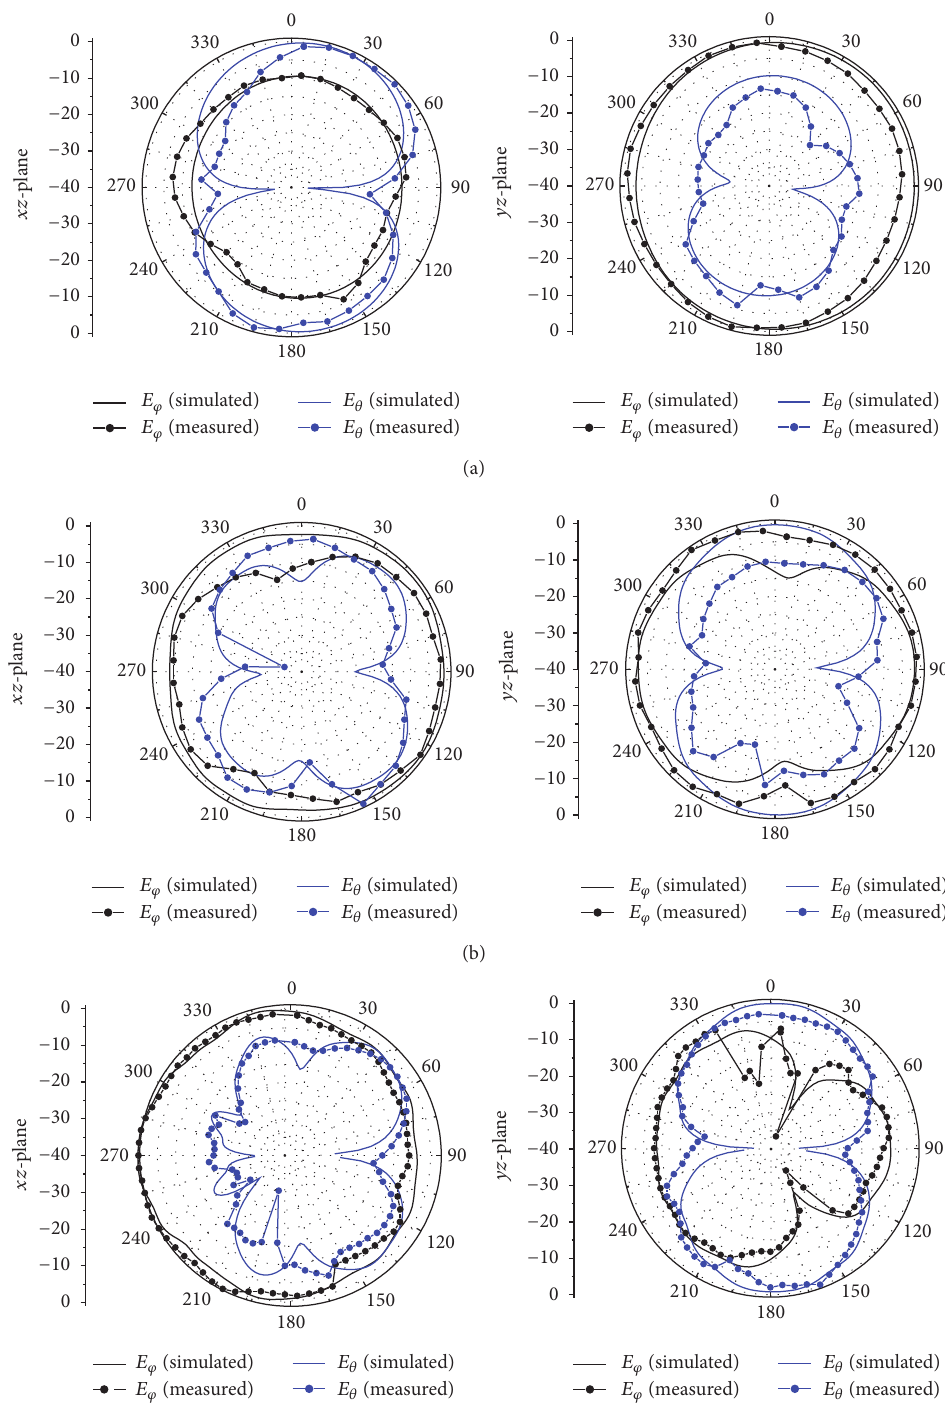
Figure 9: Measured and simulated radiation patterns for the proposed antenna: at (a) 900 MHz, (b) 1900 MHz, and (c) 2450